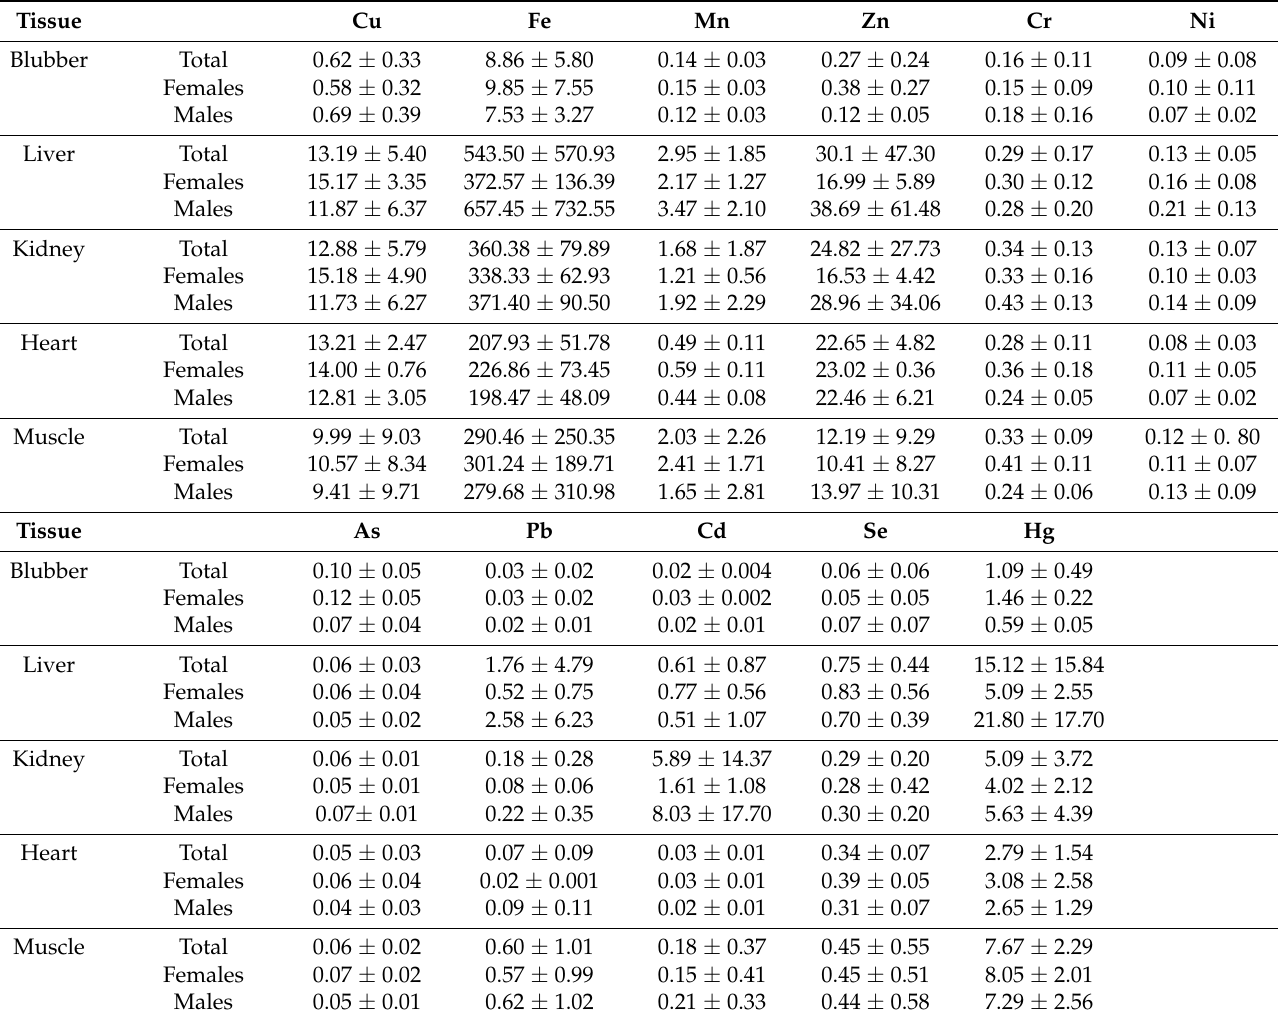
Table 3. Concentrations of trace elements in Caspian seal tissues collected from 2013 to 2016 in Iran, expressed as M ± SD (mg/kg w.w.). The total number of samples for all tissues was 20:10 from females and 10 from